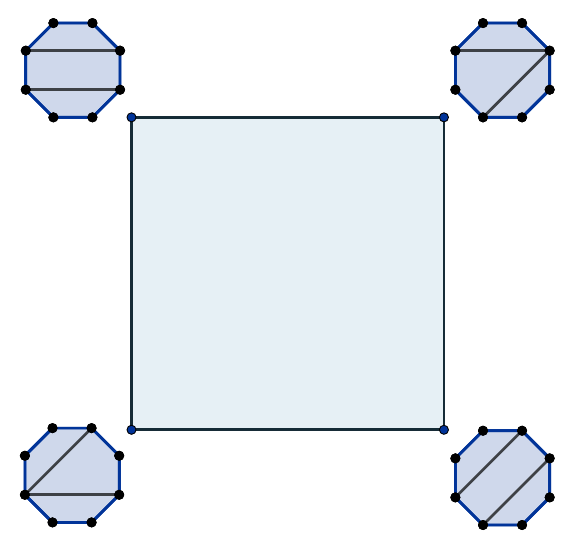
Figure 5 . Accordiohedron for dissection (14 , 58)